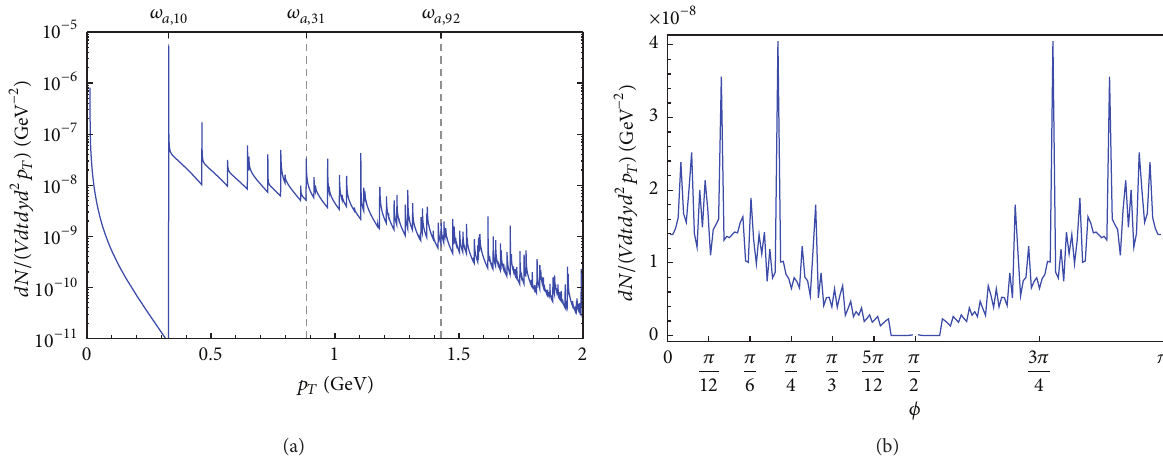
Figure 20: Photon spectrum in one-photon annihilation of 𝑢 and 𝑢 quarks. 𝑒𝐵 = 𝑚 2 𝜋 , 𝑦 = 0 . (a) 𝑘 ⊥ -spectrum at 𝜙 = 𝜋/3 , (b) azimuthal angule distribution at 𝑘 ⊥ = 1 GeV. Adopted from